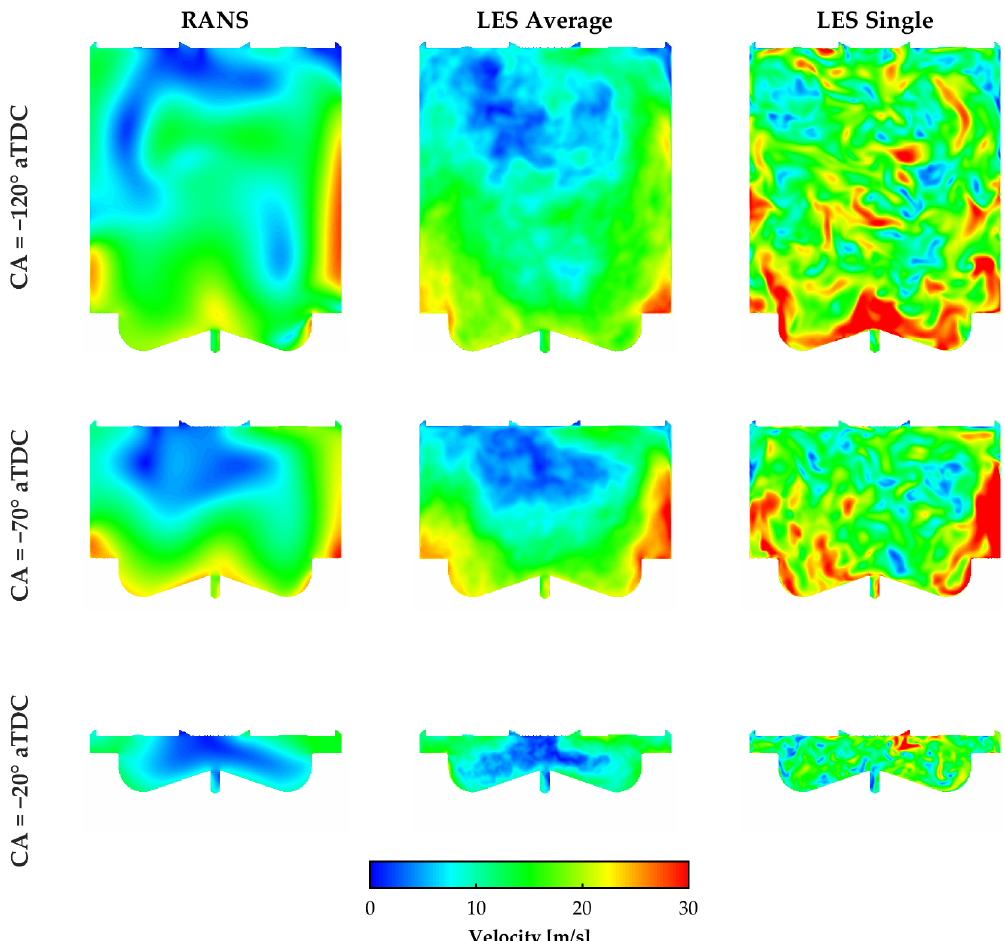
Figure 1. Flow field of a large bore dual fuel engine during compression stroke at 3 different crank angles simulated with Large Eddy Simulation (LES) ( right ) and URANS ( left ); averaged LES results from 25 cycles are shown in the ( middle column ).